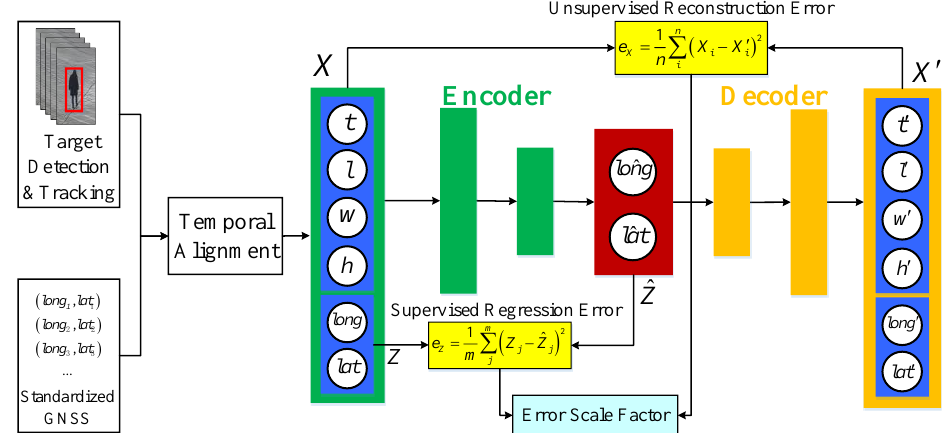
Figure 3. Framework of Stage One, with a hybrid stacked auto-encoder backbone.